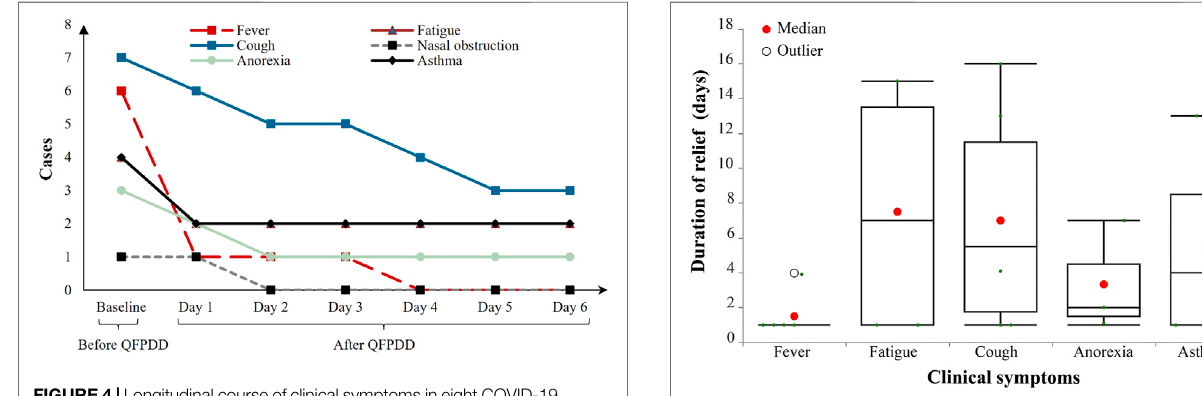
FIGURE 5 | Duration of major clinical symptoms in eight COVID-19 cases